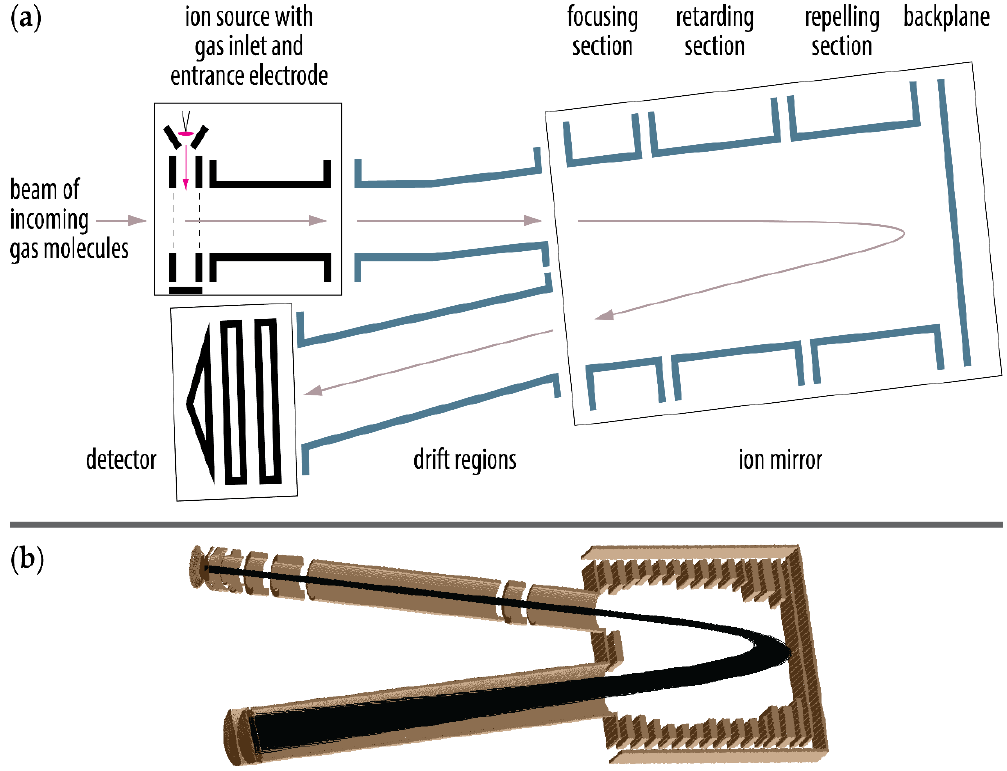
Figure 1. Outline of the ion-optical system ( a ) and its SIMION ® model ( b, to